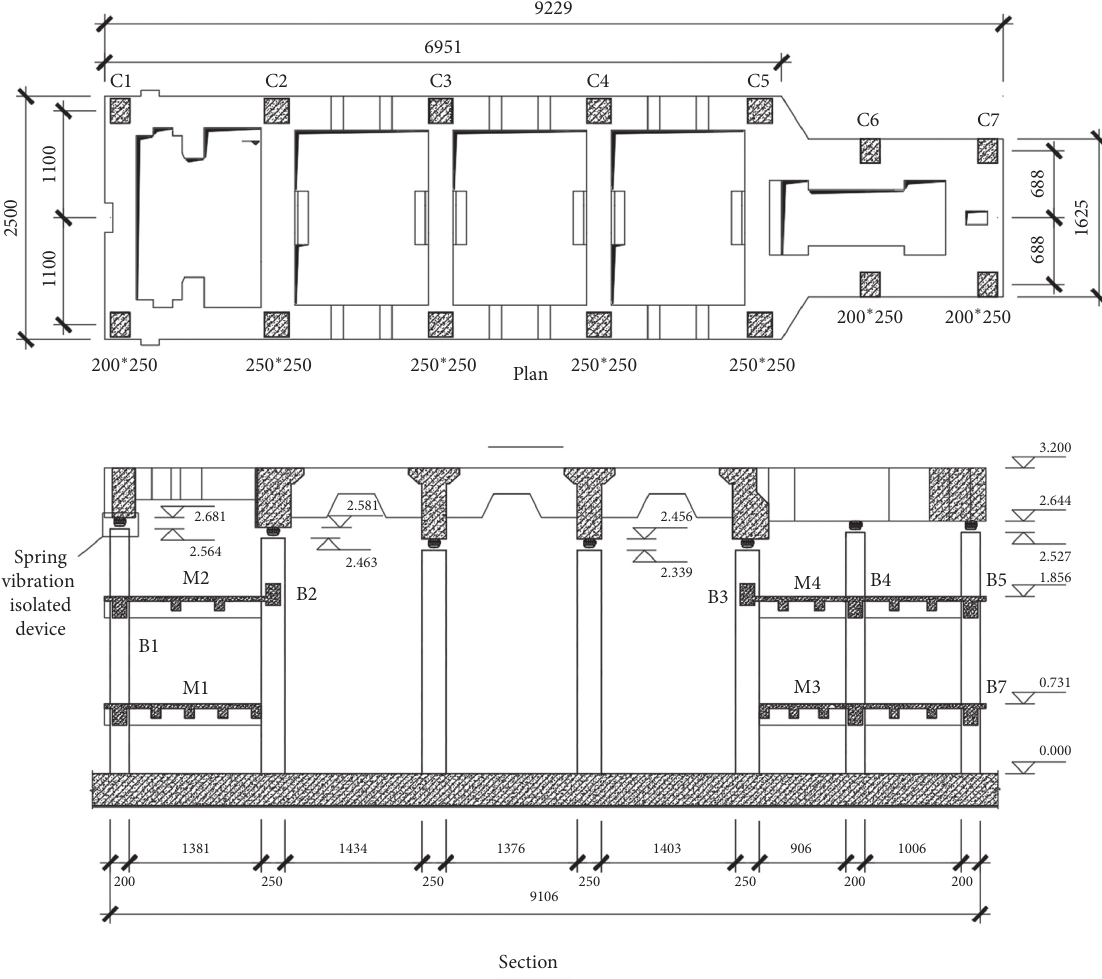
Figure 3: Layout drawing of test model (mm). Table 1: Similarity relation of scale model.